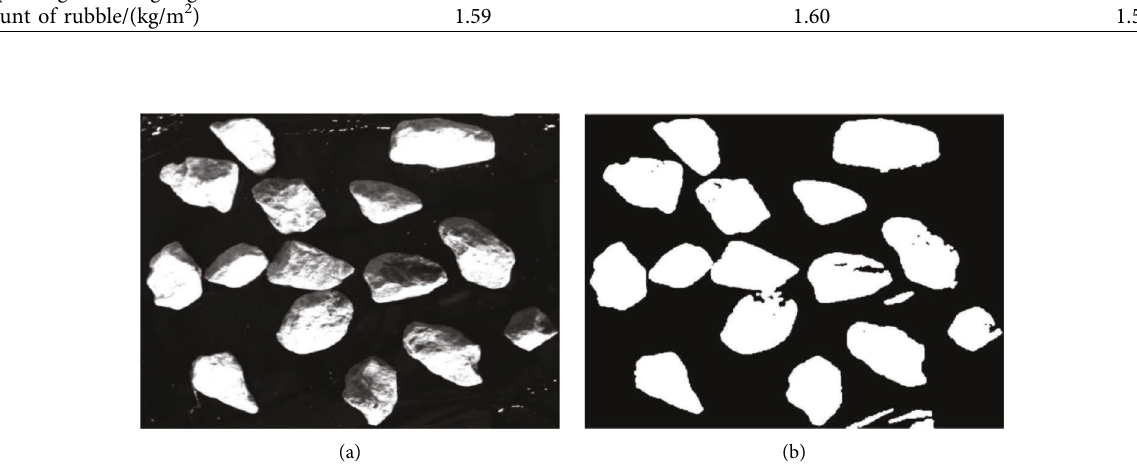
Figure 15: 16-19mm original image and inspection